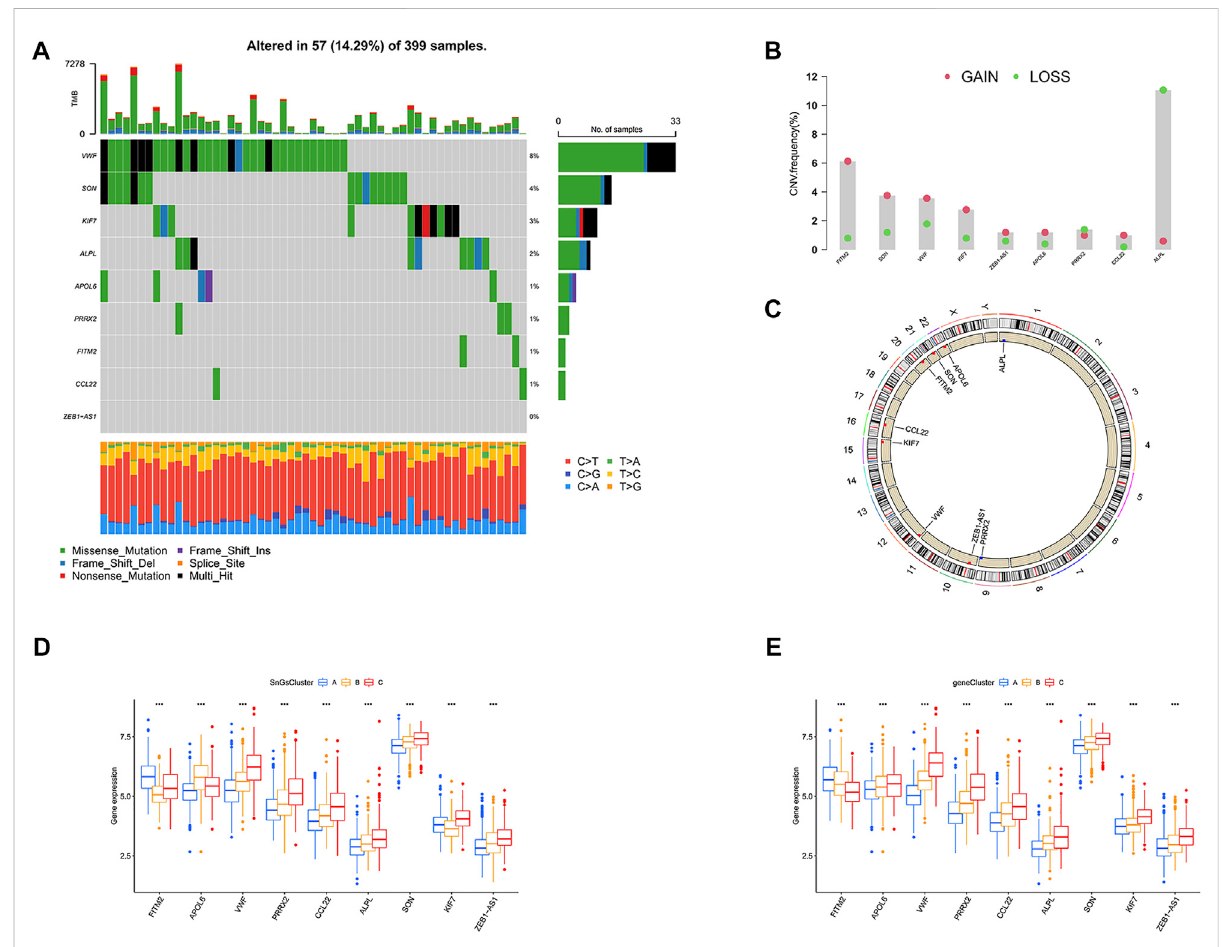
FIGURE 11 The landscape for mutation and expression of the 10 signature genes (FITM2, APOL6, VWF, PRRX2, CCL22, ALPL, SON, KIF7, and ZEB1-AS1). (A) The gene mutation frequency waterfall plot of 10 signature genes. (B) CNV alteration frequency of the 10 signature genes; Red, CNV gain;